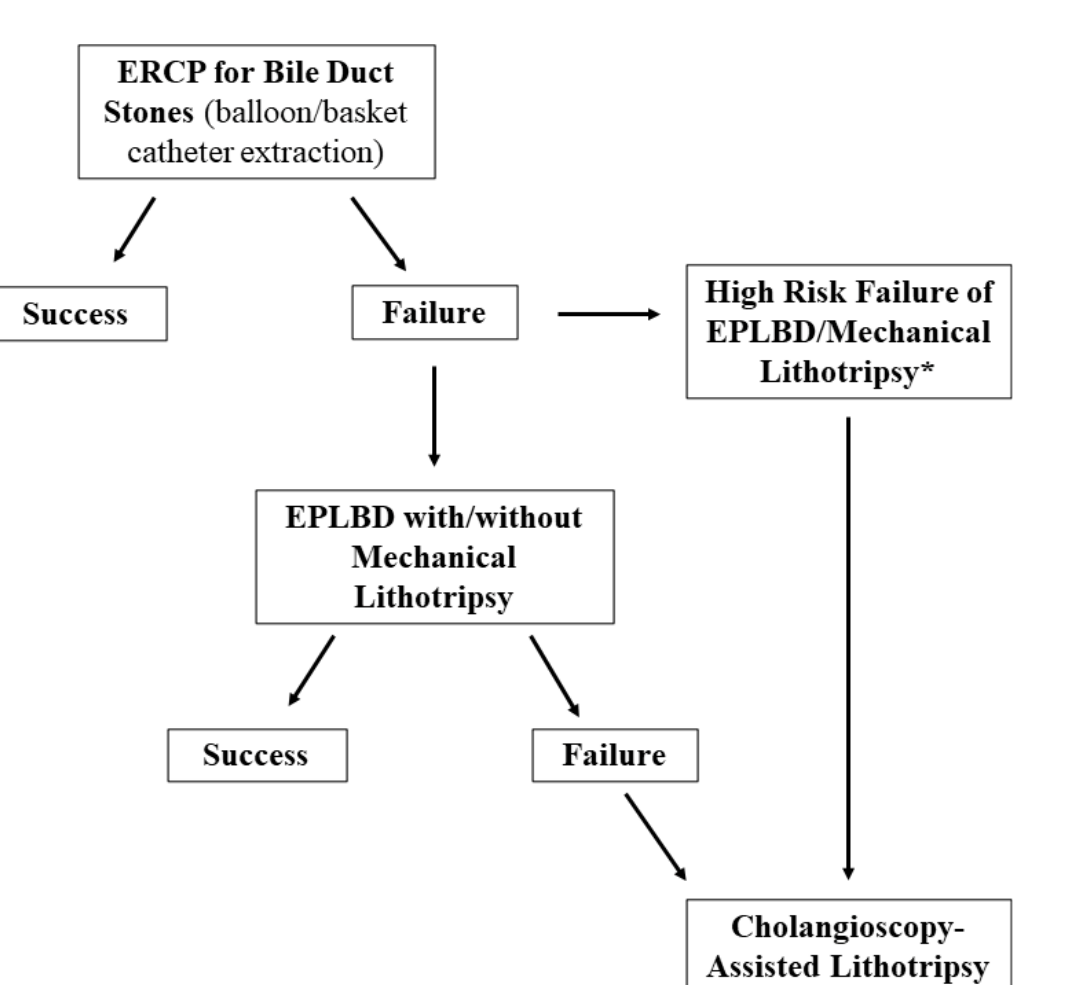
Figure 5. Flowchart for management of biliary stones. EPLBD, Endoscopic Papillary Large Balloon Dilation. * risk factors for failure of EPLBD or mechanical lithotripsy: stone impaction, size above 30 mm, stone size/extrahepatic bile duct ratio > 1, tapered bile duct.